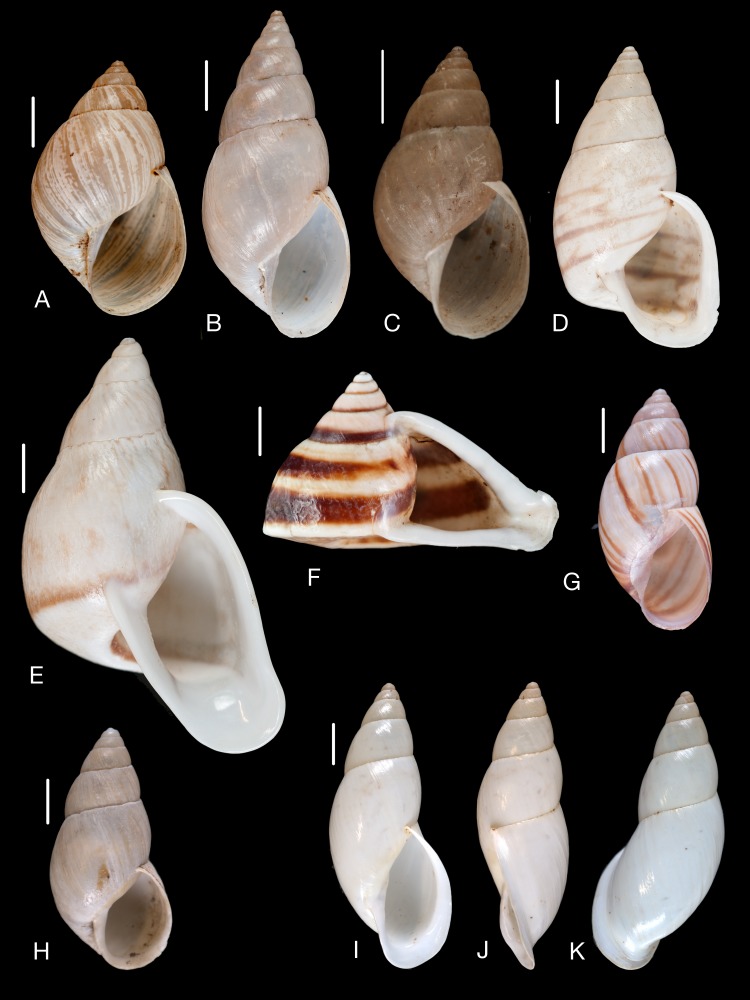
Material collected by the CCP.(A–K) Bulimulidae. Bulimulus apodemetes (d’Orbigny, 1835), MNCN 15.05/12990, (A) ventral view; Bulimulus bonariensis (Rafinesque, 1833), MNCN 15.05/21562, (B) ventral view; Bulimulus tenuissimus (Férussac in Férussac & Deshayes, 1832), MNCN 15.05/13204, (C) ventral view; Cochlorina aurismuris (Moricand, 1838), MNCN 15.05/13360, (D) ventral view; Cochlorina aurisleporis (Bruguière, 1792), MNCN 15.05/7181, (E) ventral view; Cochlorina navicula (Wagner, 1827), MNCN 15.05/13668, (F) ventral view; Drymaeus (Drymaeus) ambustus (Reeve, 1849), MNCN 15.05/21234, (G) ventral view; Drymaeus (Drymaeus) chenui (Philippi, 1867), MNCN 15.05/20236, (H) ventral view; Drymaeus (Drymaeus) baezensis (Hidalgo, 1869), MNCN 15.05/7354, (I) ventral view, (J) lateral view (lip), (K) dorsal view. Scale line 5 mm.